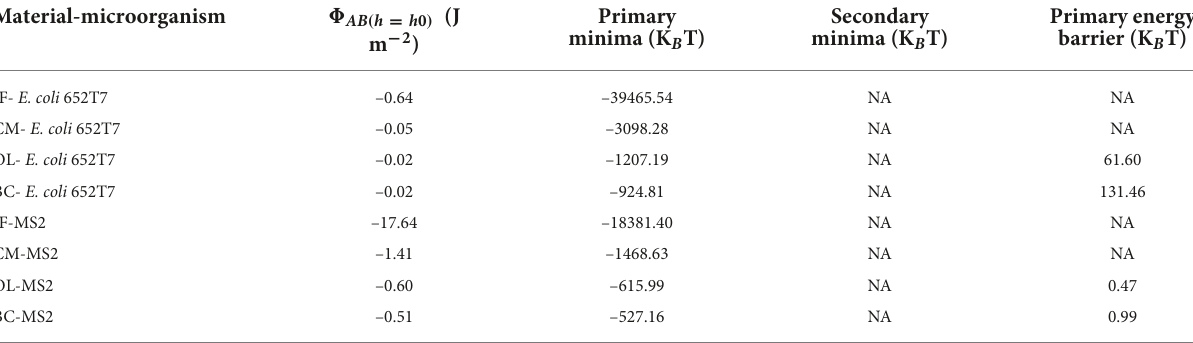
TABLE 3 Estimated values of XDLVO interaction energy parameters.